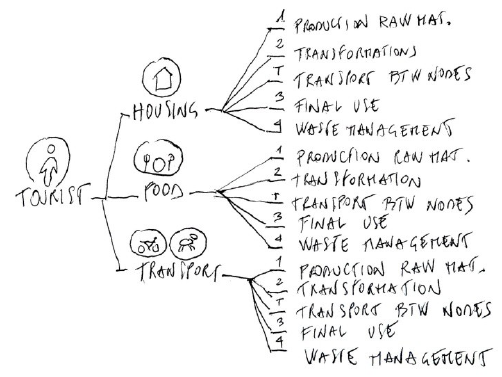
Figure 7. Branched scheme of the main flows associated with a tourist typical day.